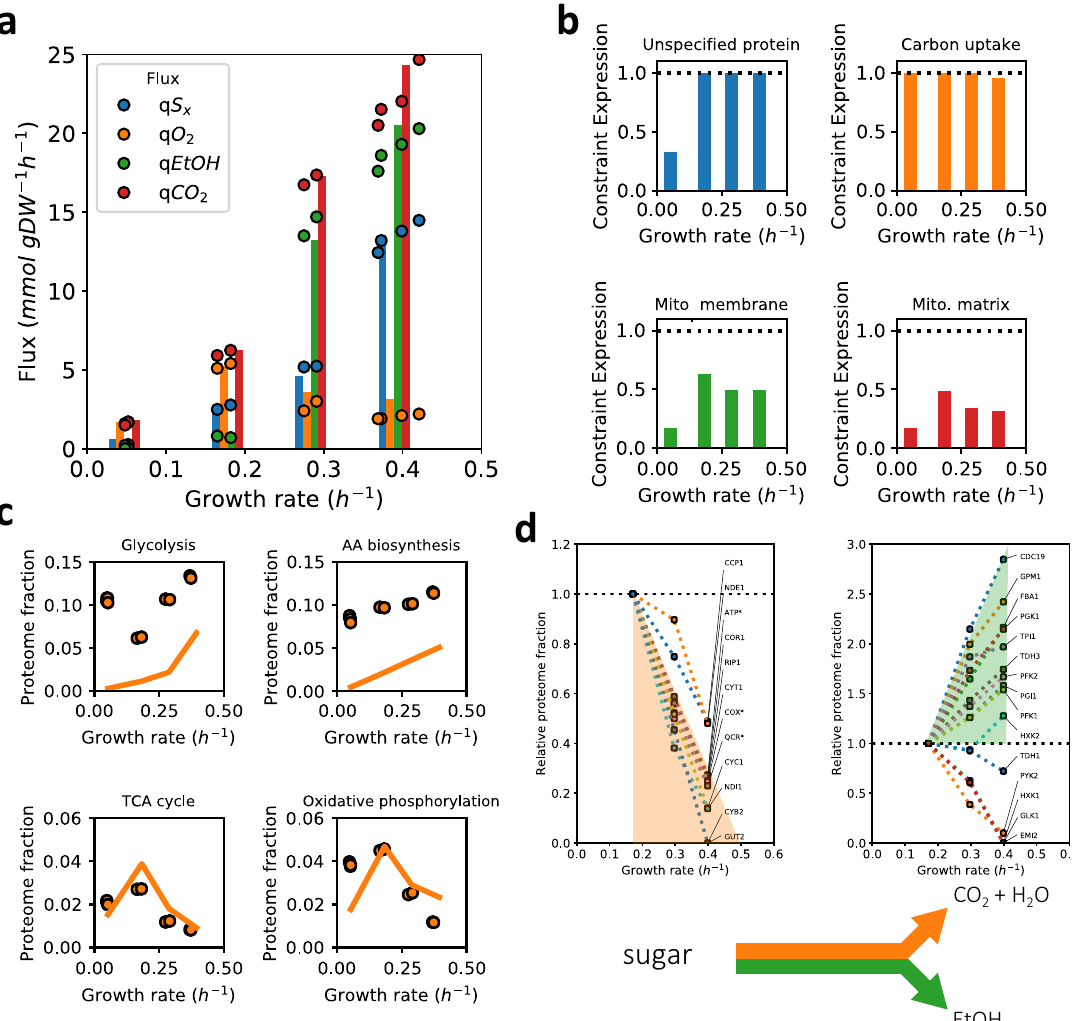
Fig. 4 Predicted and measured physiology of S. cerevisiae CEN.PK strain in sugar batch cultivations. Model predictions, fl uxes and protein levels plotted as a function of growth rate during hexose sugar excess conditions (in the order: trehalose, galactose, maltose, glucose) a Fluxes of sugar consumption, oxygen consumption and ethanol production. Circles are experimental data, bar plots indicate model predictions (of both the growth rate and fl uxes); b Predicted active constraints under the different sugar excess conditions as predicted by the mode (see legend of Fig. 2 for details). c Comparison of predicted minimally needed proteome fractions with experimentally determined ones suggests differences in saturation level between pathways. Lines represent the model, experimental data are circles; d Linearity of the expression of individual enzymes in glycolysis (right) and respiration (left) with growth rate suggests trading in of respiratory protein for fermentative protein. Asterixes indicate aggregated proteome fractions instead of fractions of individual proteins. The respiratory proteins converge at 0.474± 0.0002 h − 1 . Shading in top plots of panel ( d ) highlights the common trend of individual protein abundance, corresponding to the end-products in the scheme on the bottom. Individual proteins in panels c and d were mapped to metabolic